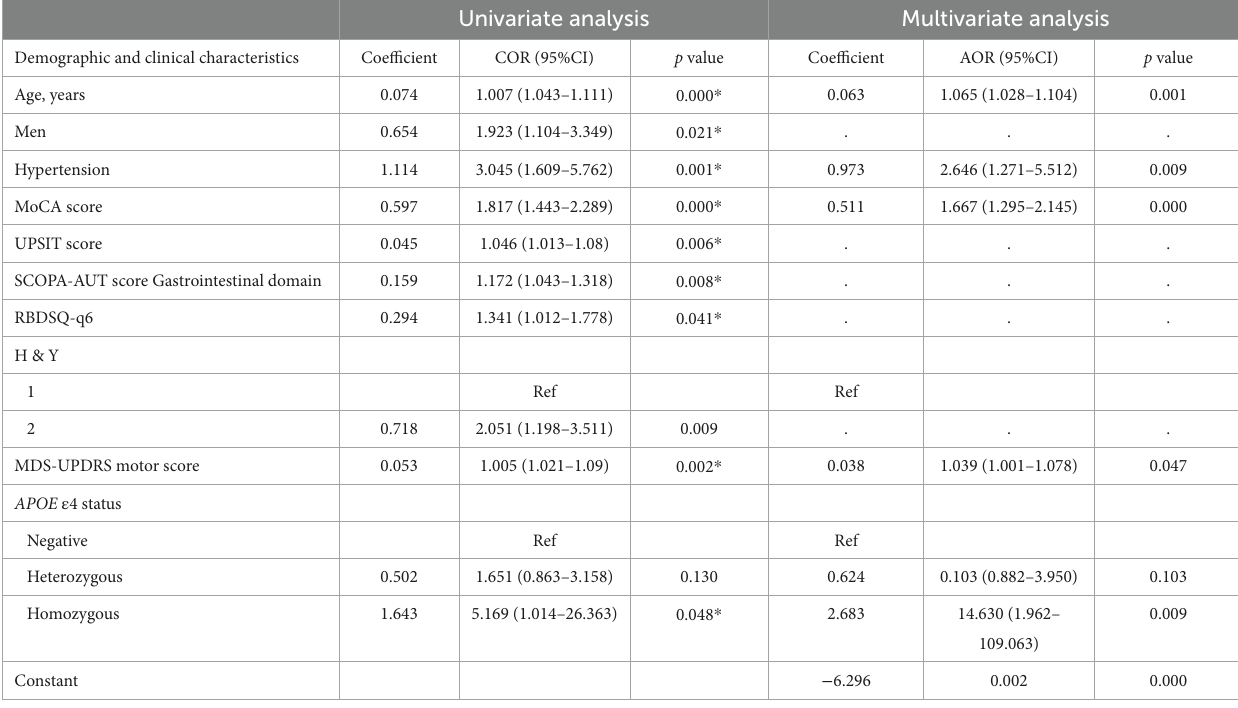
TABLE 2 Univariate and multivariate logistic regression analyses show associations between risk factors and cognitive impairment in patients with newly diagnosed Parkinson’s disease (less than 2 years). Univariate